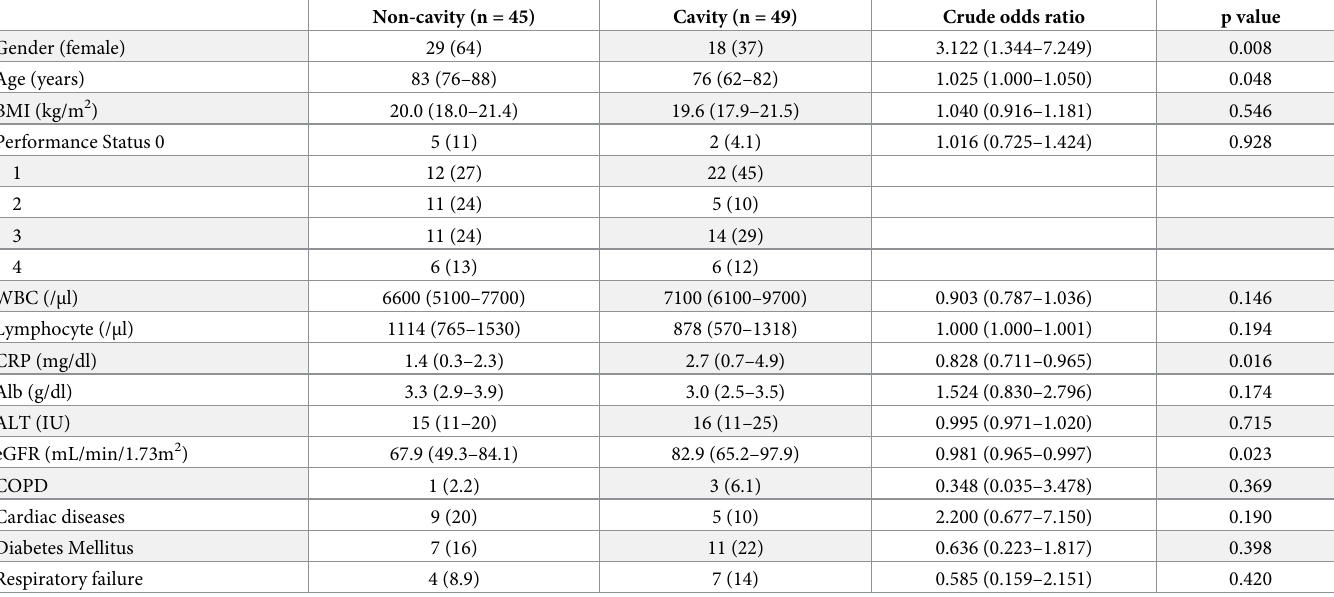
Table 1. Univariate logistic regression analysis of baseline characteristics associated with non-cavity disease.